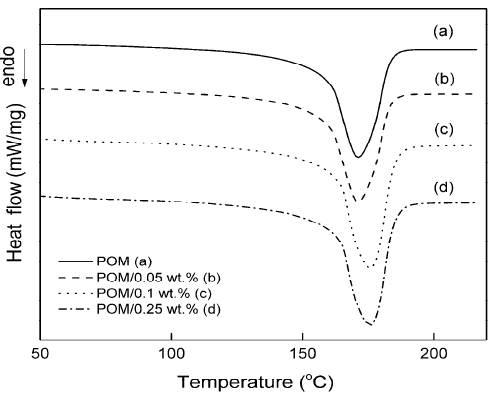
Figure 2. Differential scanning calorimetry (DSC) melting curves of pure POM ( a ) and its composites with different GPOSS concentrations at the first heating rate of 20 °C/min: ( b ) 0.05 wt. %; ( c ) 0.1 wt. %; ( d ) 0.25 wt. %.